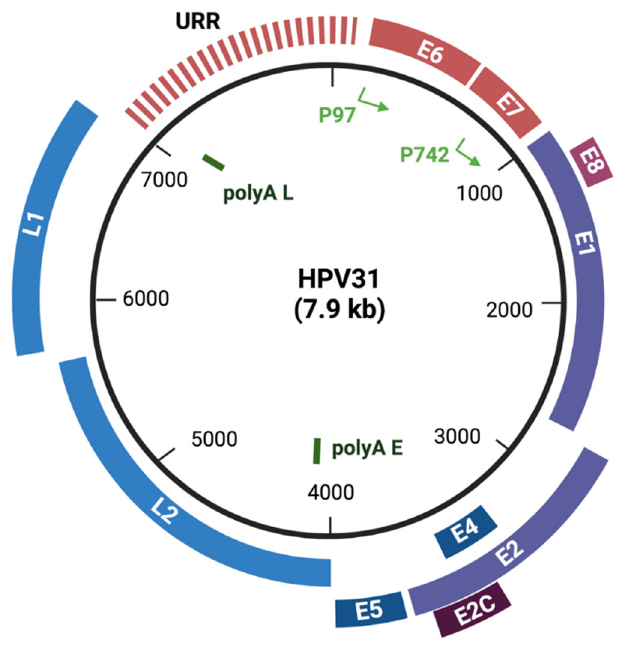
Figure 1. HPV genome structure map of high-risk HPV31. Viral genomes consist of two main coding regions: early (E) and late (L). The early (E) transcripts are initiated at the p97 promoter and are expressed in the lower portion of stratified epithelia. The E6 and E7 open reading frames encode oncogenes that target p53 and Rb, respectively, as well as other cellular proteins. E1 and E2 are the two replication proteins, while E4 and E5 function in the later stages of viral life cycle in suprabasal cells. E8^E2C is a repressor generated by splicing that regulates copy number. Late (L) gene transcription initiates upon differentiation from the p742 promoter and expresses high levels of E1^E4 as well as E5 along with the capsid proteins L1 and L2. The URR is a noncoding region harboring the origin of viral replication and enhancers to regulate viral promoters. HPV31 genome organization is similar to that of other high-risk HPVs such as HPV16 and 18. (Created with BioRender.com, 24 June